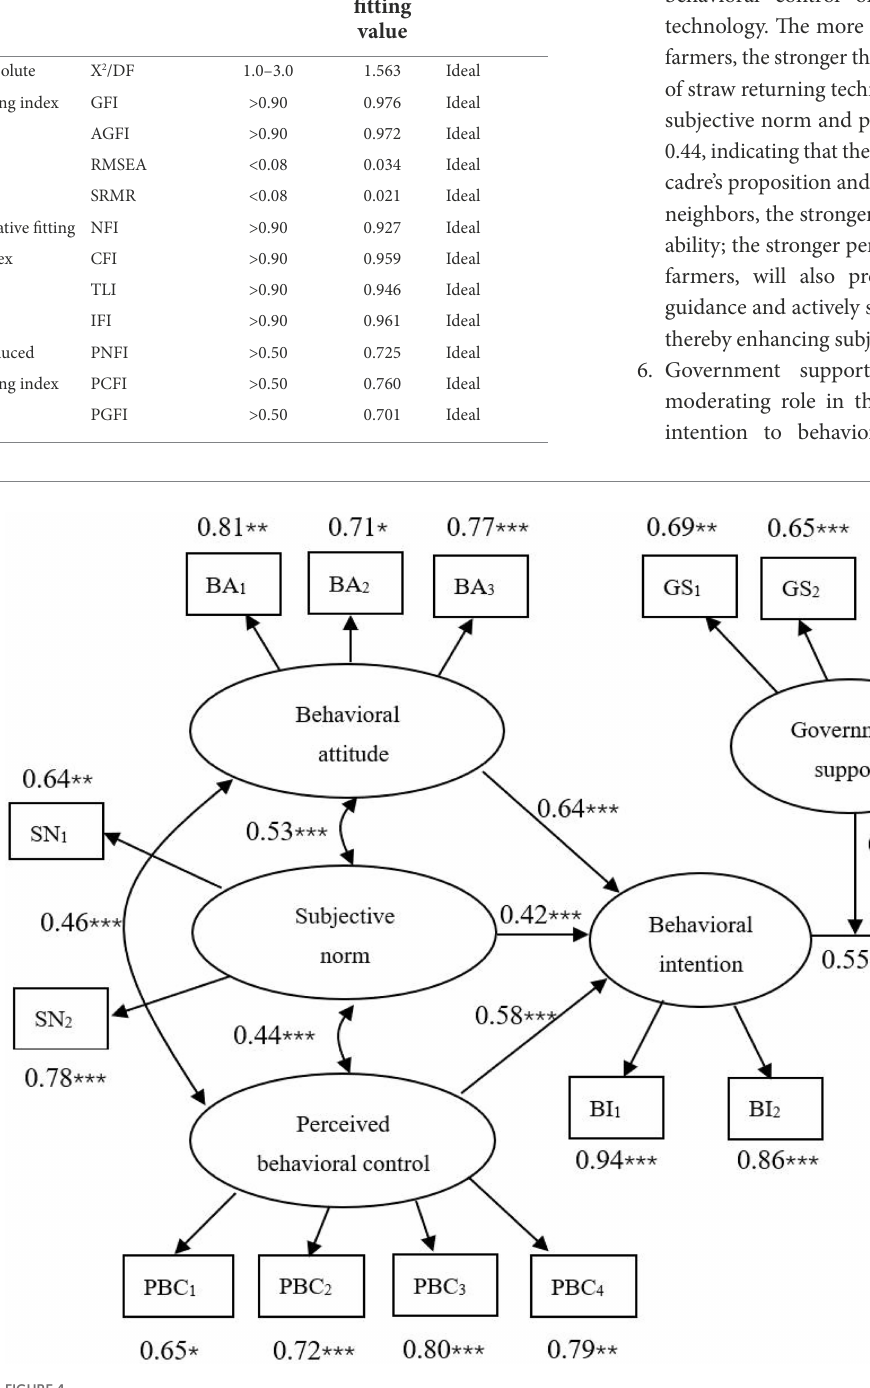
FIGURE 4 Structural equation model and standardized path coefficient diagram. * p < 0.10, ** p < 0.05, *** p < 0.01. BA, Behavioral attitude; SN, Subjective norms; PBC, Perceived behavioral control; GS, Government support; BR, Behavioral response; BI, Behavioral